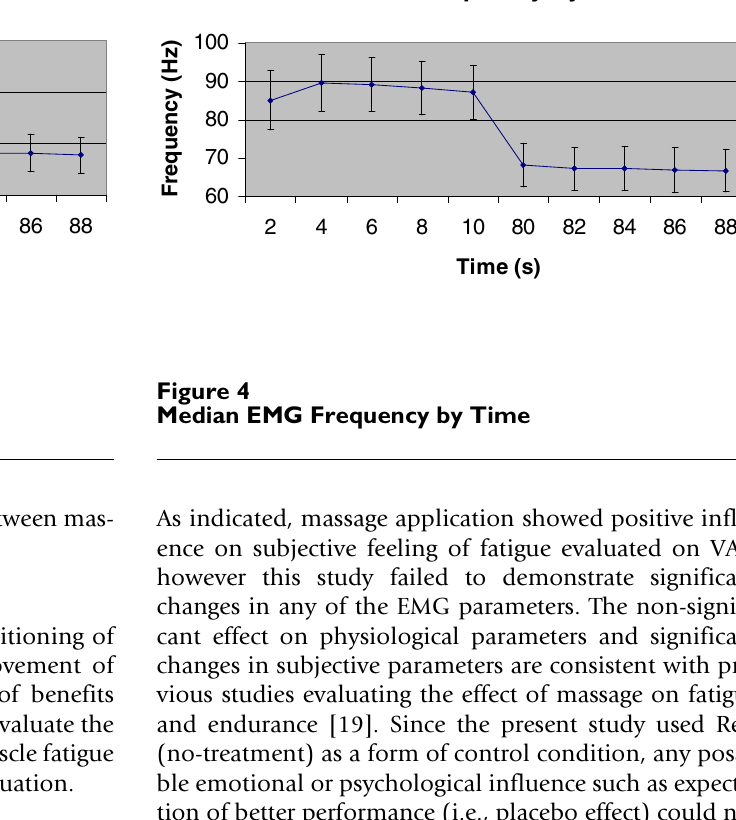
Mean EMG Frequency (Squared) by Time